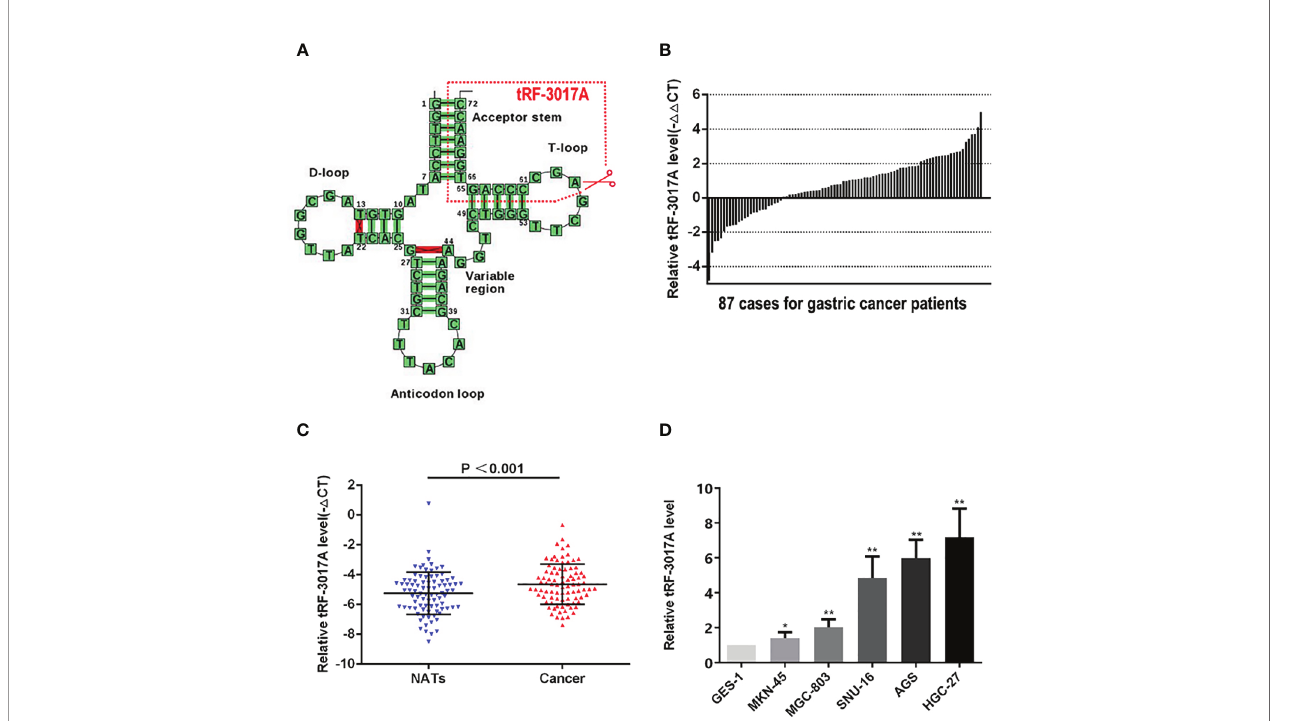
FIGURE 1 | Expression of tRF-3017A in GC tissues and cell lines. (A) tRF-3017A is a 3 ’ fragment of mature tRNA-Val-TAC. The speci fi c cleavage site is located at the T-loop. Image from tRNADB (http://trna.bioinf.uni-leipzig.de/DataOutput/Result?ID=tdbD00011005). (B) Expression level (- DD Ct) of tRF-3017A was quanti fi ed in GC tissues compared with matched-paired NATs among 87 GC patients by qRT-PCR, and U6 RNA was used as a qRT-PCR control for tRF-3017A. Each column represents up/down-regulated tRF-3017A expression in one GC patient. (C) Expression of tRF-3017A was upregulated (- D Ct, paired t test) in GC tissues relative to matched-paired NATs among 87 GC patients by qRT-PCR. (D) Expression of tRF-3017A in GC cell lines. GES-1, human gastric mucosal epithelial cell, was used as a qRT-PCR control. *P < 0.05; **P <